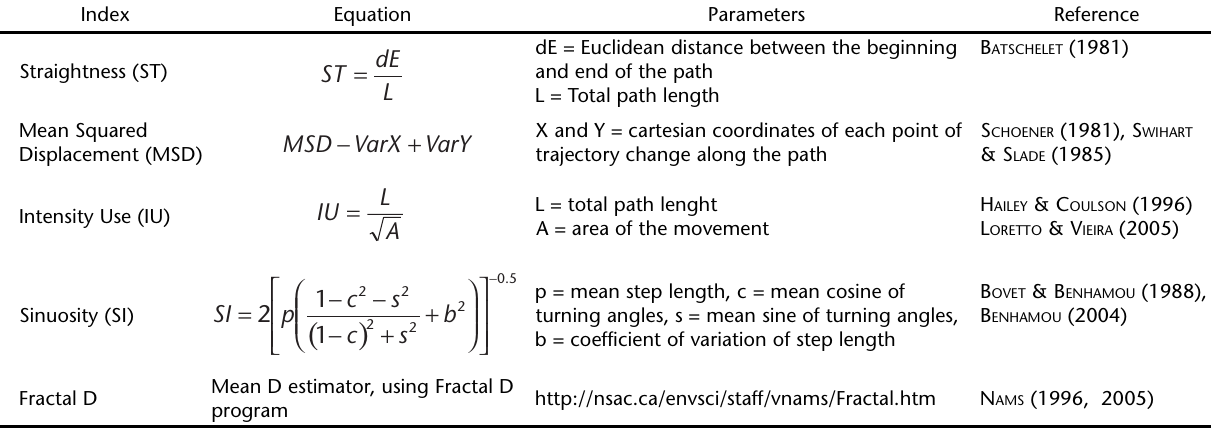
B ATSCHELET (1981)